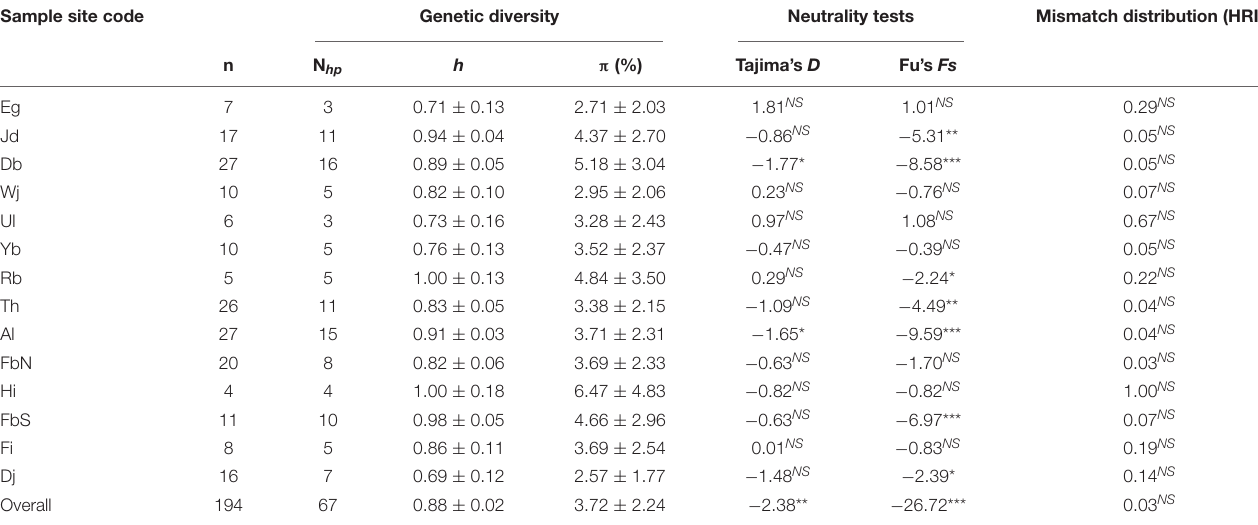
TABLE 2 | Sample sites, number of sequences (n), number of haplotypes (N hp ), haplotype diversity ( h ), nucleotide diversity ( π ), Tajima’s D , Fu’s Fs and Harpending’s raggedness index (HRI) for Tridacna maxima in the